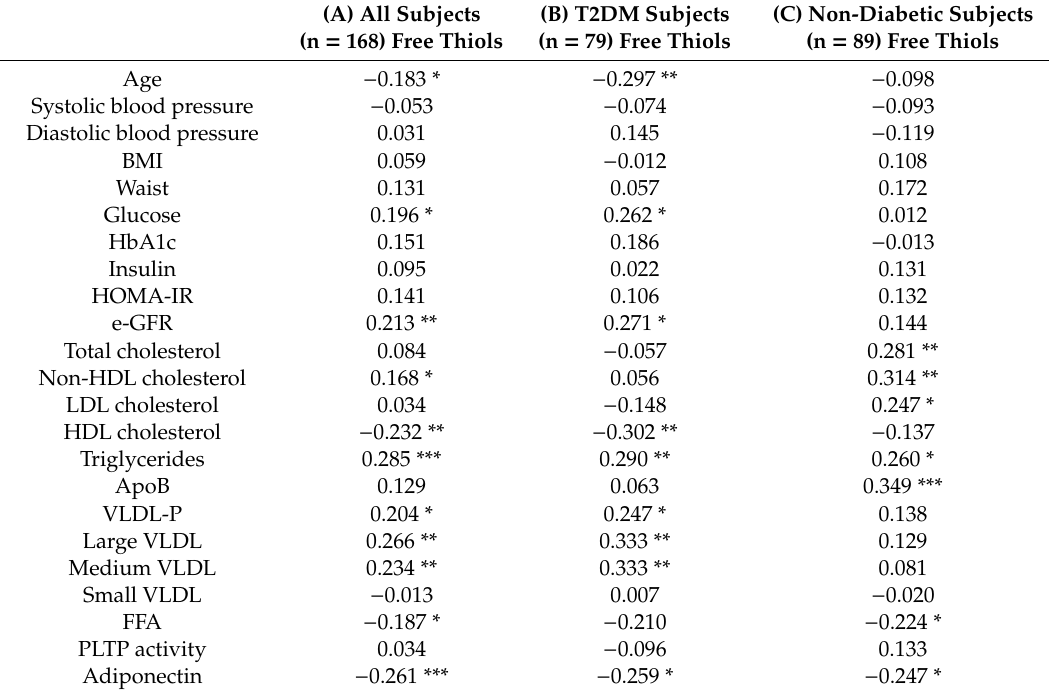
Table 2. Univariate relationships of plasma free thiols with clinical and laboratory variables in